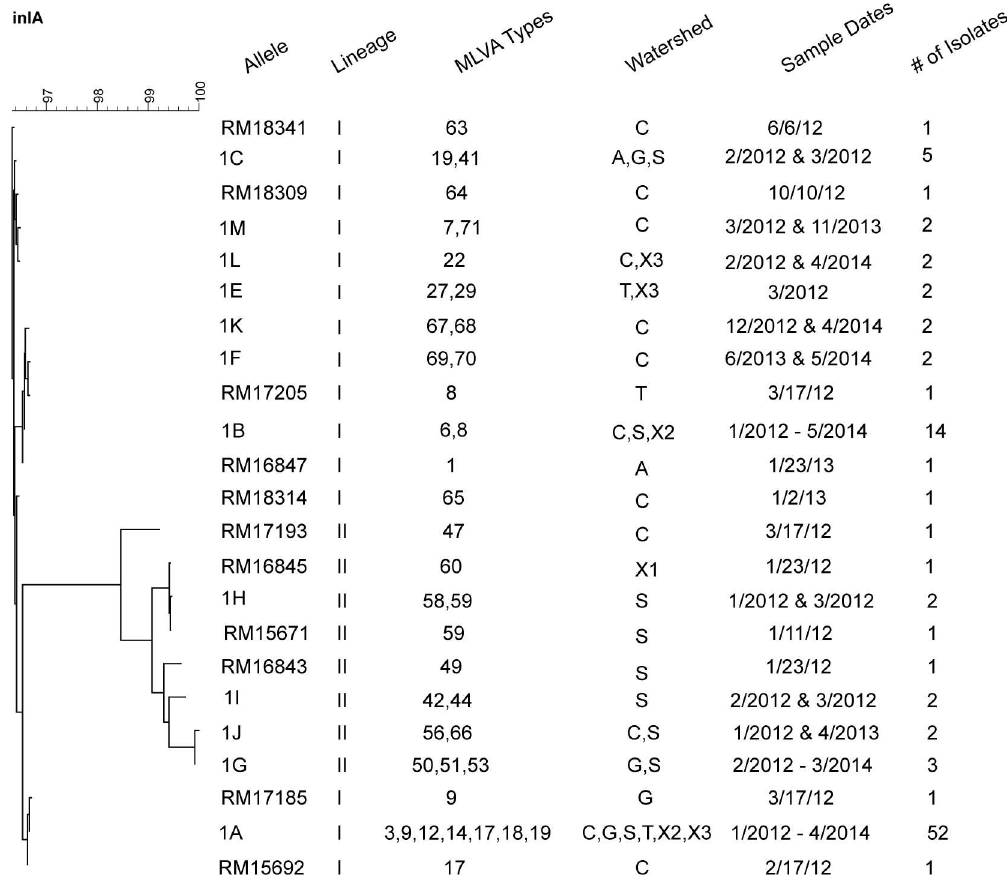
alleles. Also listed are the Lineageinformation and MLVA types in which the allelesare found, watershed information, sample dates, and the numberof isolates of each allele. Watershed information: A, Alisal; C, Carr